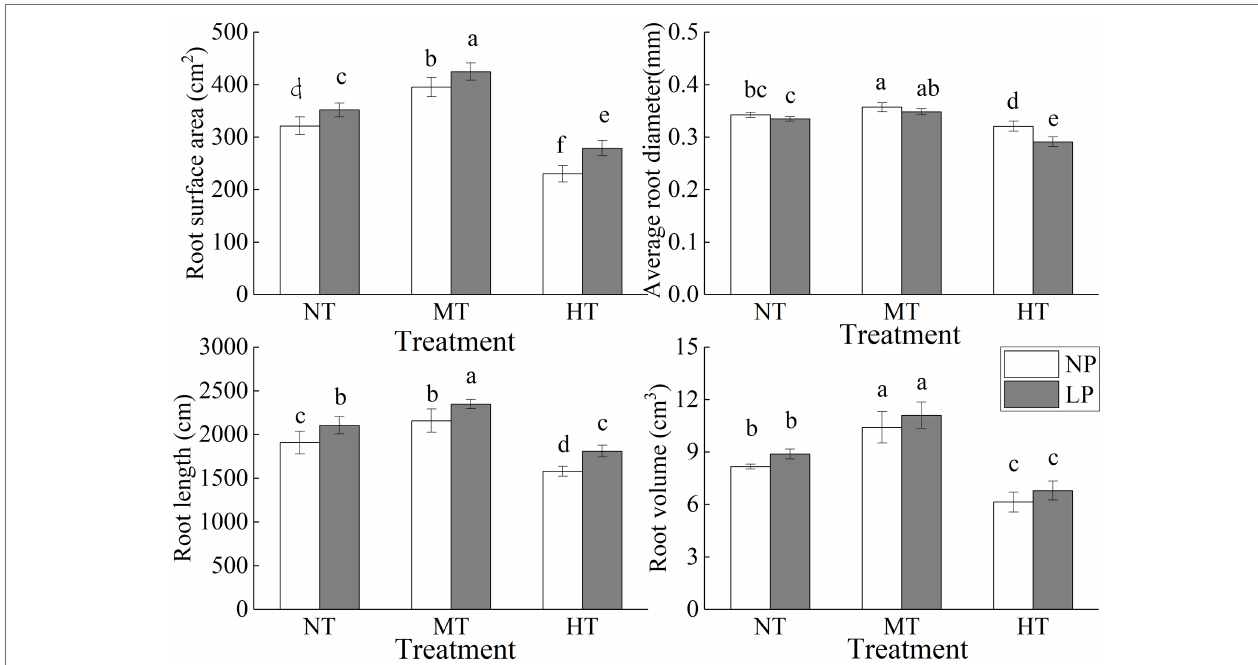
FIGURE 1 | Effect of root zone temperature and phosphorus content on root surface area, average root diameter, root volume and total root length. NT: 24 ° C, MT: 30 ° C, and HT: 36 ° C (root zone temperature); LP: 1.25 μ m and NP: 250 μ m (phosphorus content). Notations above bars of a, b, c, d, e and f indicate homogeneous groups ( α =